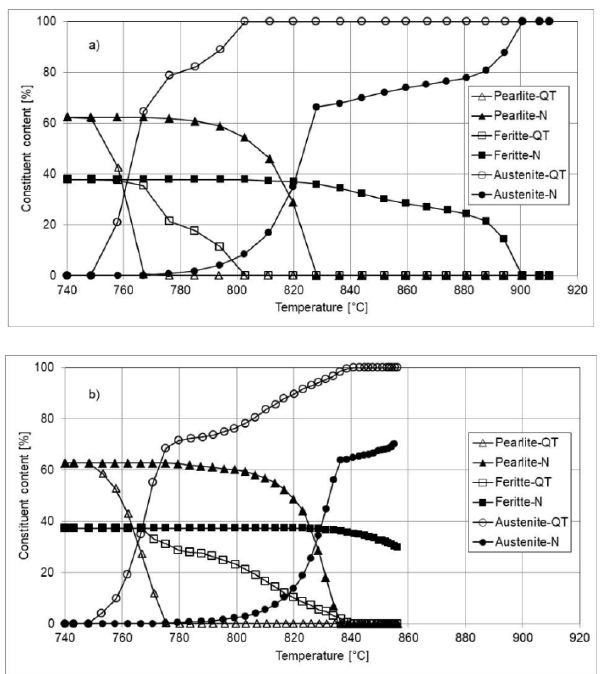
Figure 6. Temperature-dependent respective volume fraction evolutions of the emerging austenite ( A ) and the disappearing pearlite ( P ) and ferrite ( F ): ( a ) Case 1 (N1, QT1); ( b ) Case 2 (N2, QT2).